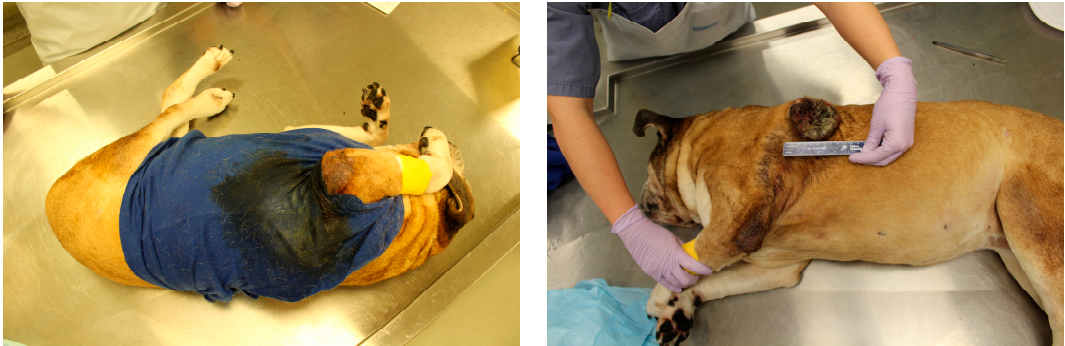
Figure 5. Lateral view of the dog with the t-shirt on demonstrating staining from the underlying necrotic mass ( left ). T-shirt removed and the large ulcerated mass revealed ( right ).